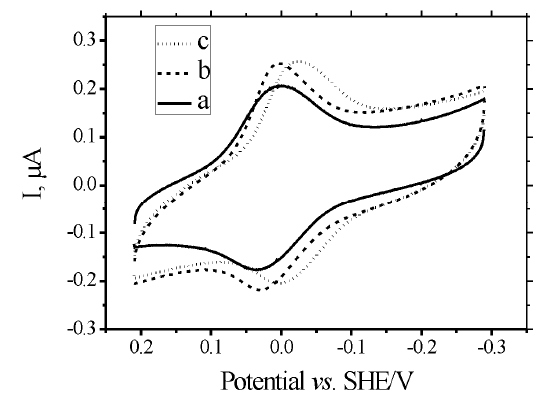
Figure 1. Cylic voltammograms recorded at MCH/Au (a),